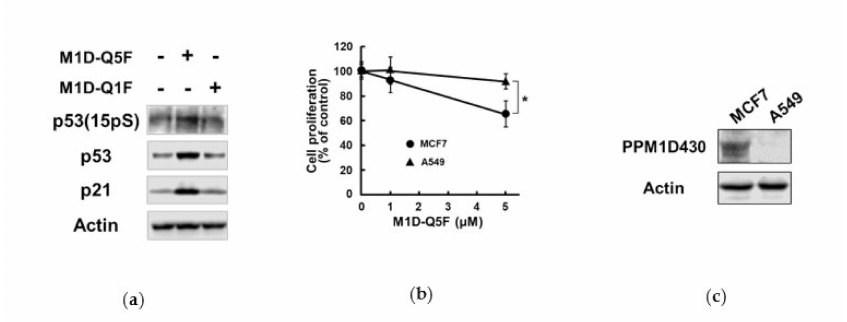
Figure 6. E ff ects of M1D-Q5F on cancer cells. ( a ) E ff ect of M1D-Q5F aptamer on p53 pathway in breast cancer MCF7 cells. Phosphorylation level of p53 at Ser15, protein level of p53 and p21 were analyzed by western blotting method. ( b ) The e ff ects of M1D-Q5F aptamer on cell proliferation of PPM1D-overexpressed MCF7 cells (circle) or A549 cells with normal level of PPM1D (triangle). Cell numbers were measured after 3 days. Data represent the mean ± S.D. (n = 6) asterisk indicates p < 0.005. ( c ) Expression level of PPM1D430 analyzed by western blotting